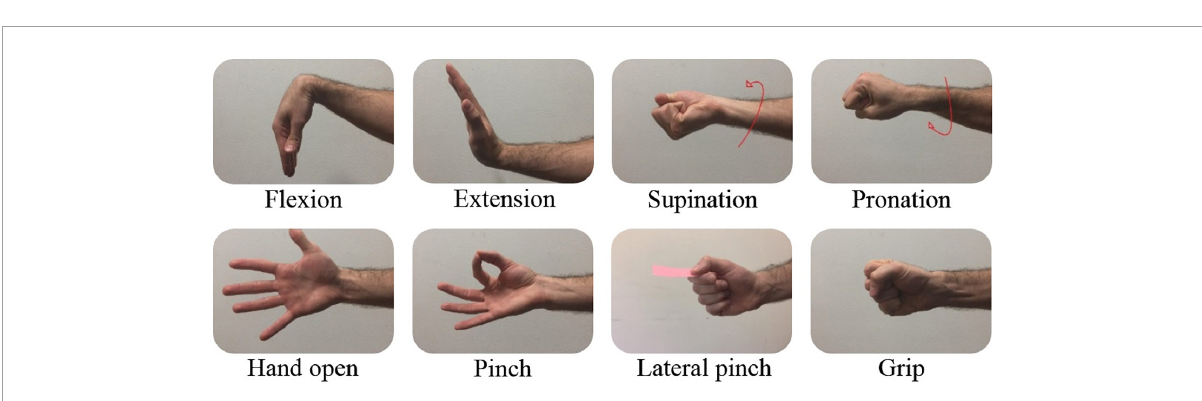
FIGURE2 Included movements. 8 Basic hand movements included in the Nearlab